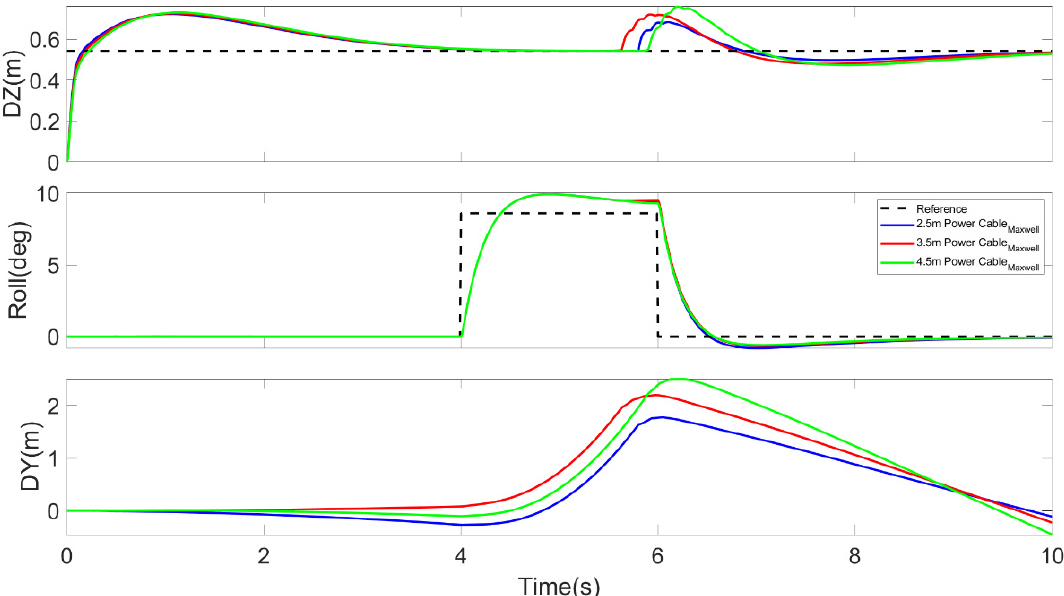
Figure 17. Altitude, roll attitude and horizontal position of the tethered multicopter during roll maneuver control simulation for various altitude conditions.